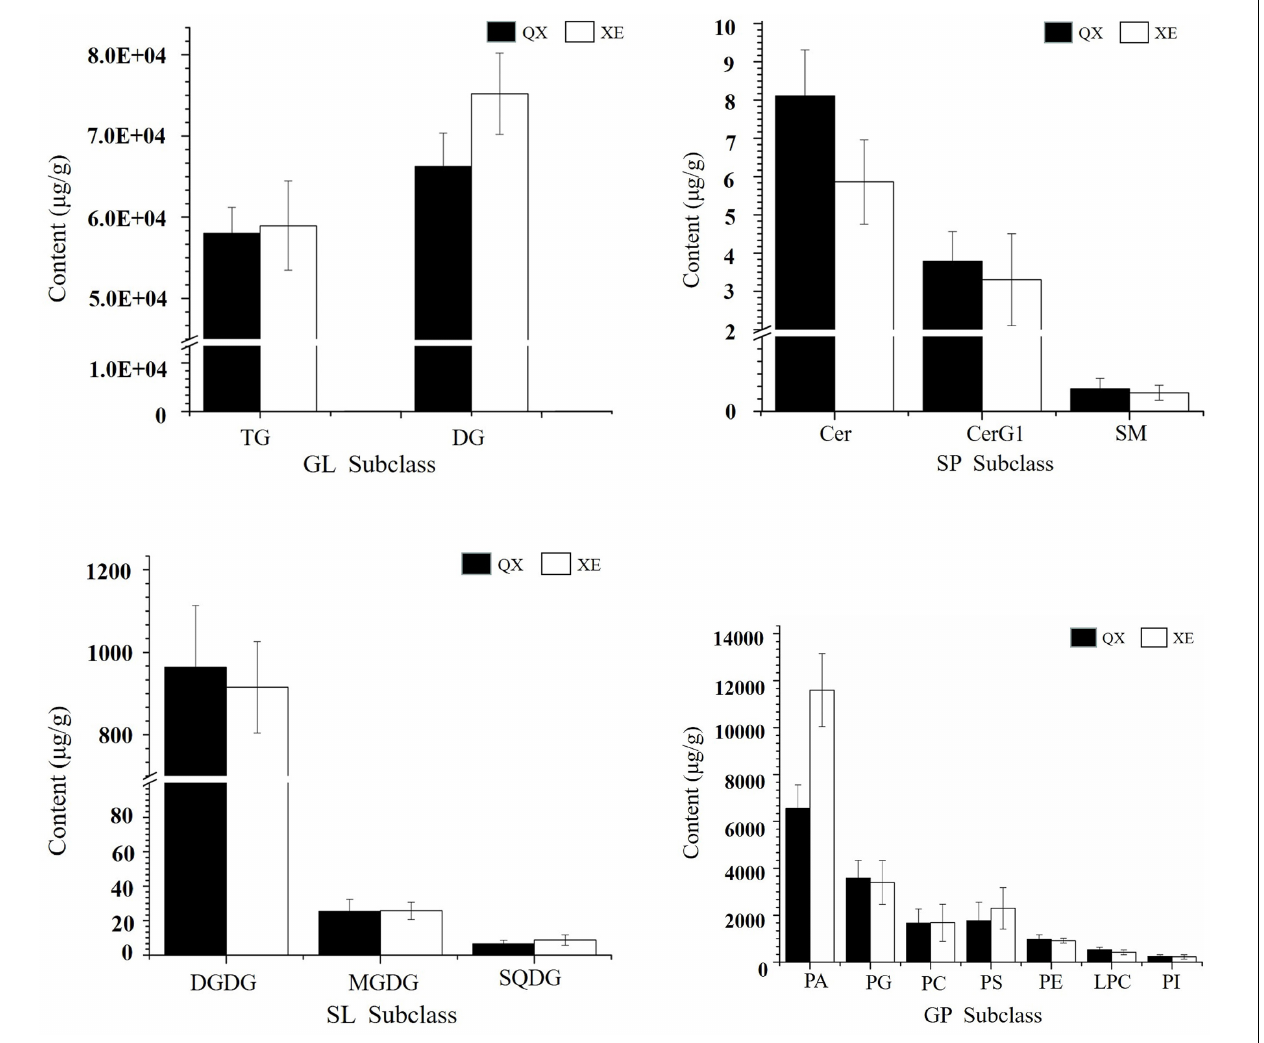
FIGURE 5 | The content of lipid subtypes in two walnut varieties. The ordinate represents the sum of the lipid molecules with the same lipid subtypes.